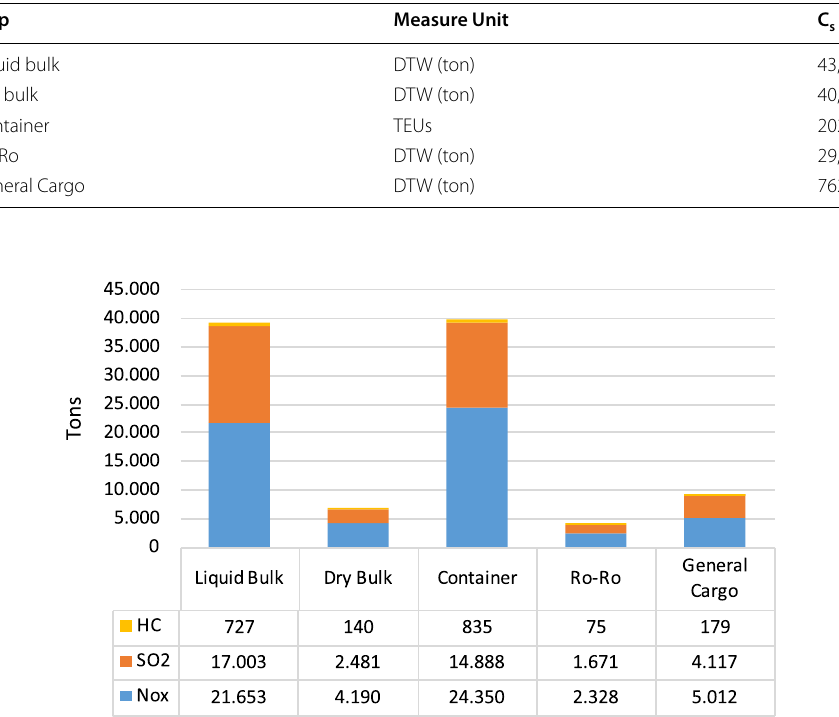
Table 11 Average ship capacity by type